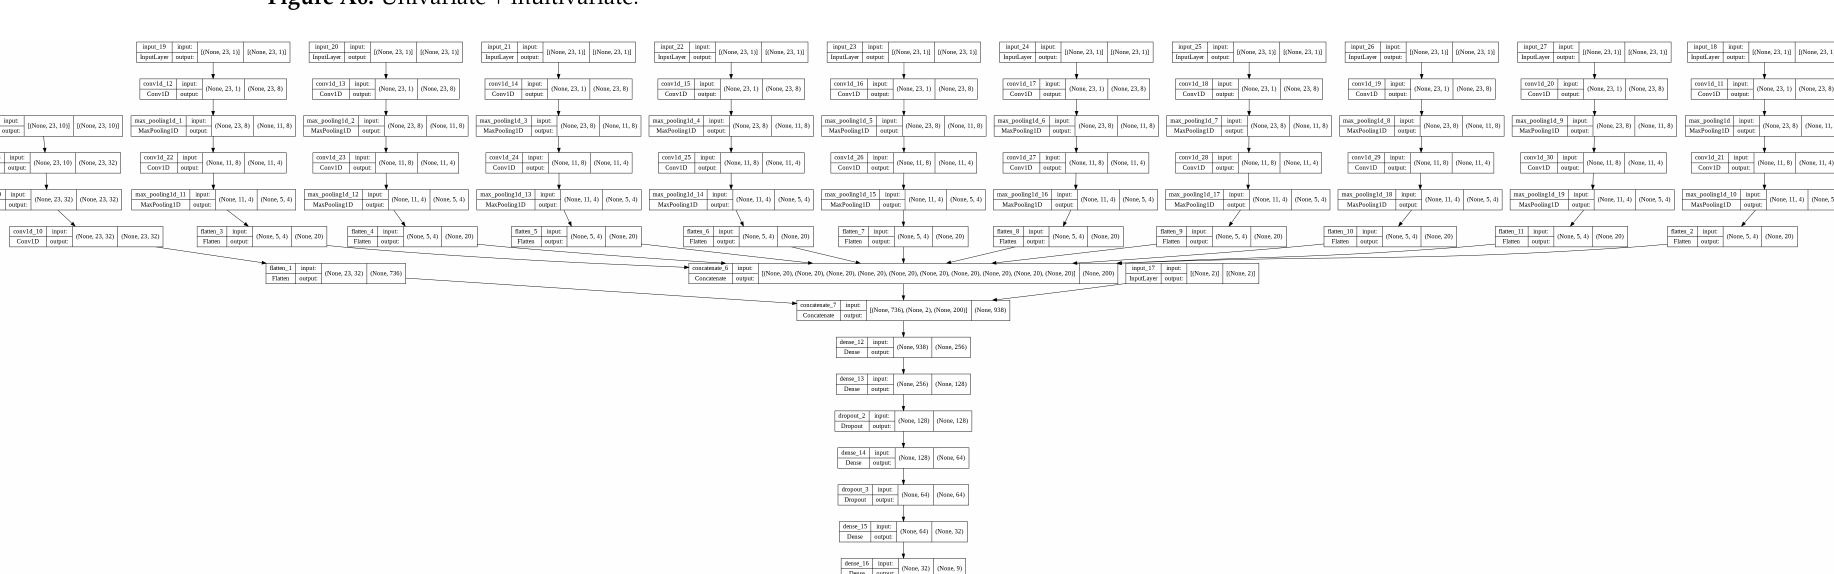
Figure A7. Univariate + multivariate +